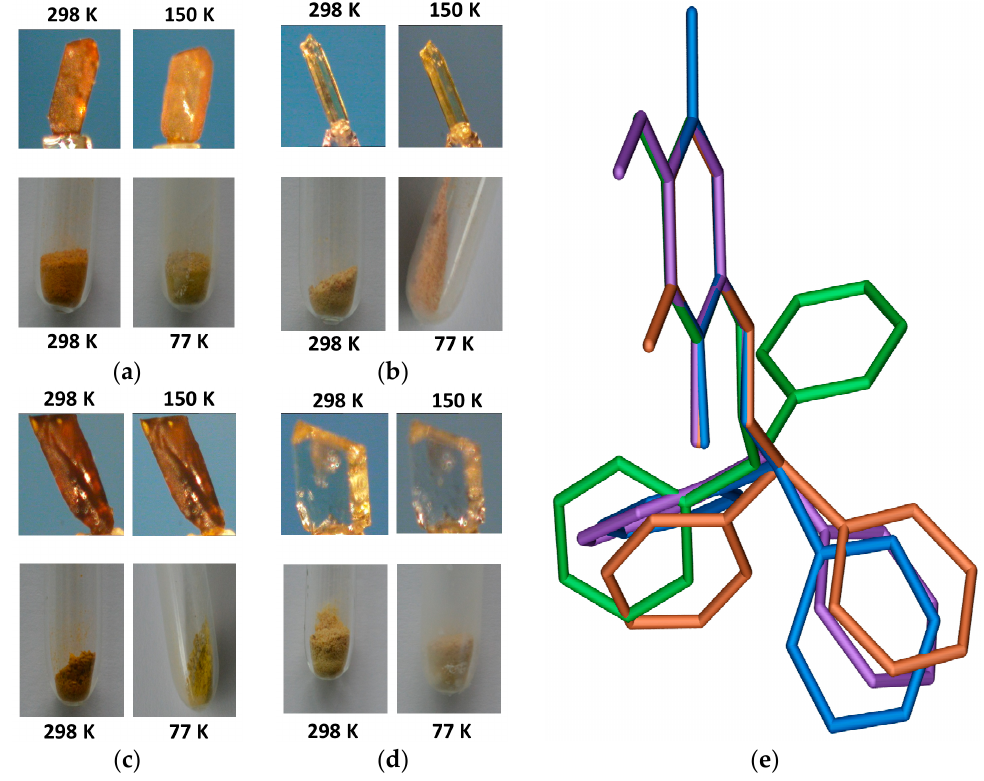
Figure 2. Photographs of single crystals and grinding products of ( a ) oOHsaladpm , ( b ) mOHsaladpm , ( c ) pOHsaladpm and ( d ) mvanadpm at 298, 150 and 77 K and ( e ) the view of the molecular overlay of oOHsaladpm (orange), mOHsaladpm (green), pOHsaladpm (blue) and mvanadpm (violet).